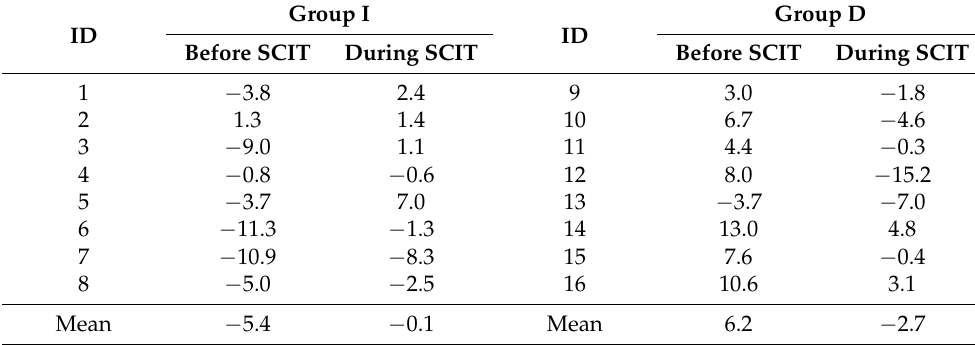
Table 1. Predicted annual change in